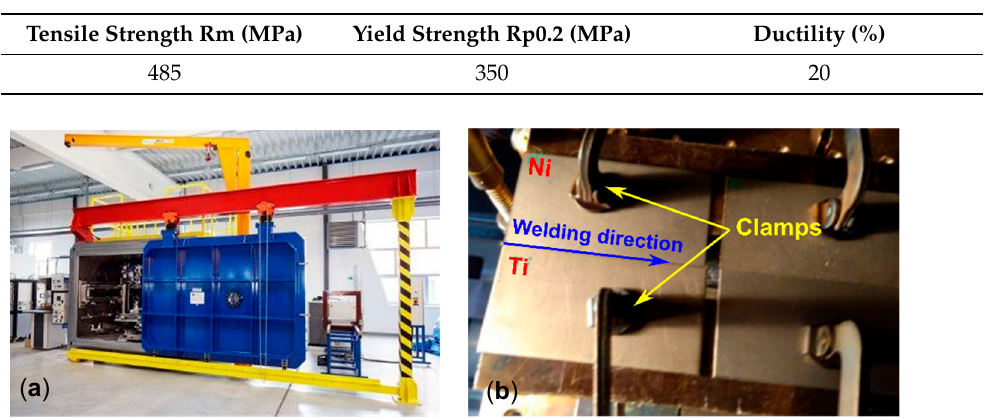
Table 4. Mechanical properties of Ti Grade 2.